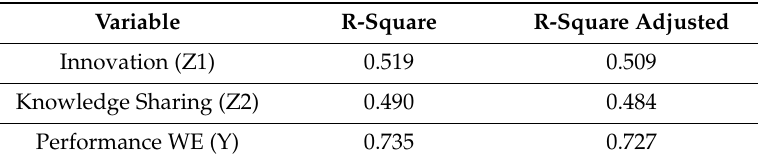
Table 3. Value Coe ffi cients of R-square.